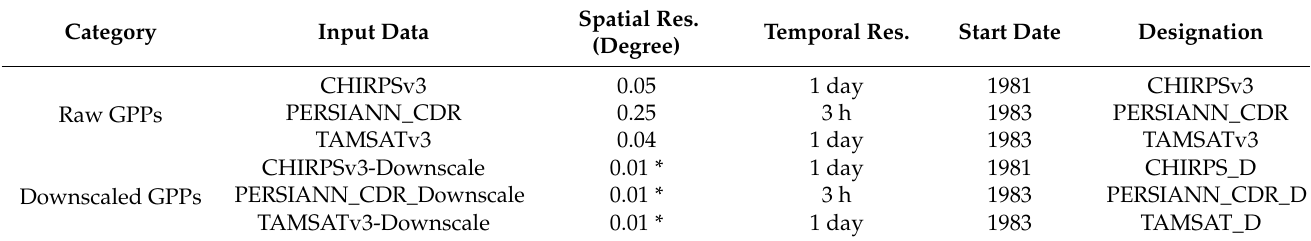
Table 1. Global precipitation products used for Wabi Shebelle River